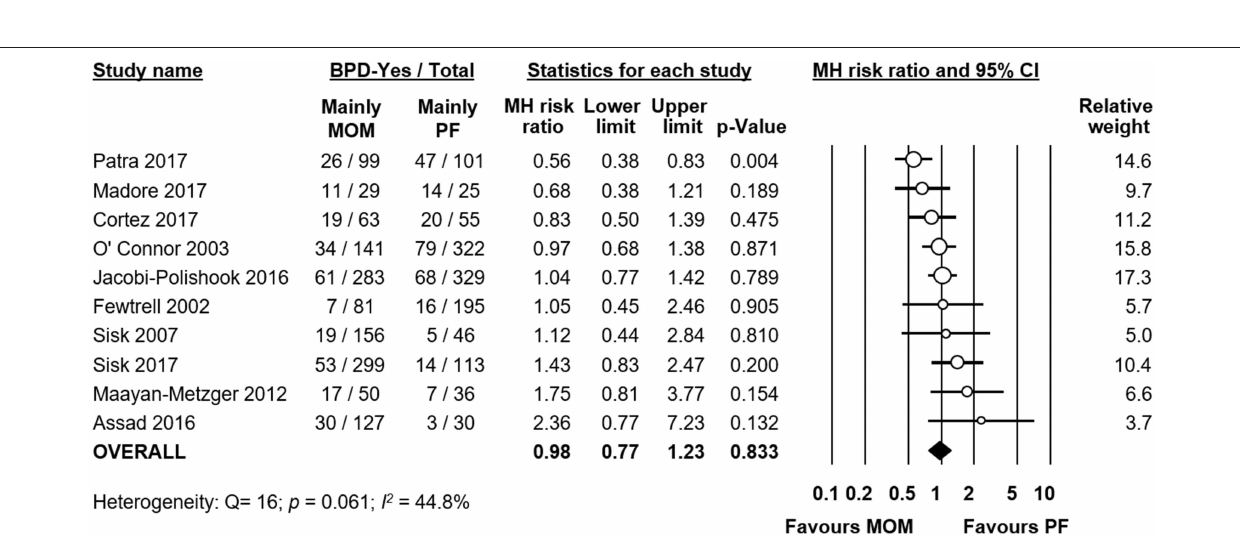
Frontiers in Pediatrics |